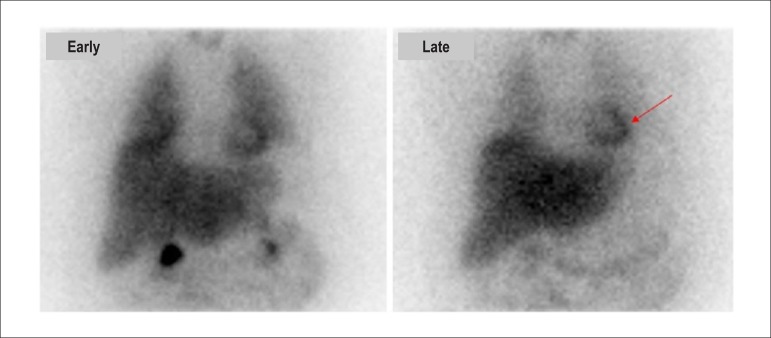
Cardiac scintigraphy with MIBG-123I showing normal radiopharmaceutical uptake in the cardiac area (arrow), which denotes preserved cardiac sympathetic activity. Black and white images of the anterior thorax, acquired approximately 15 minutes (early) and 4 hours (late) following intravenous injection of the radiopharmaceutical MIBG-123I.